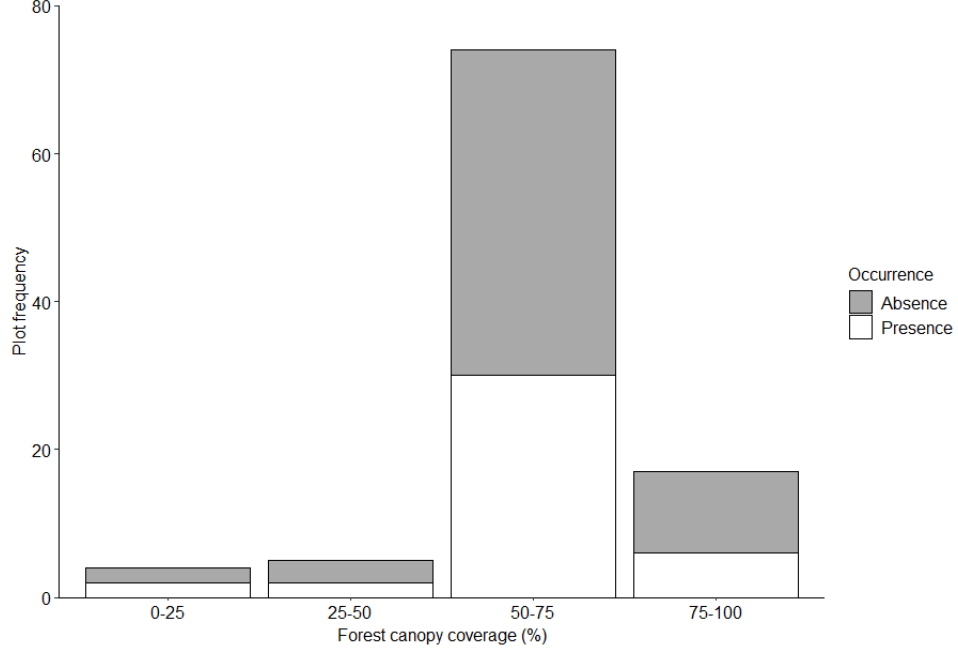
Figure 4. Chinese pangolin foraging burrow distribution by forest canopy coverage in Chandragiri Municipality, Nepal.